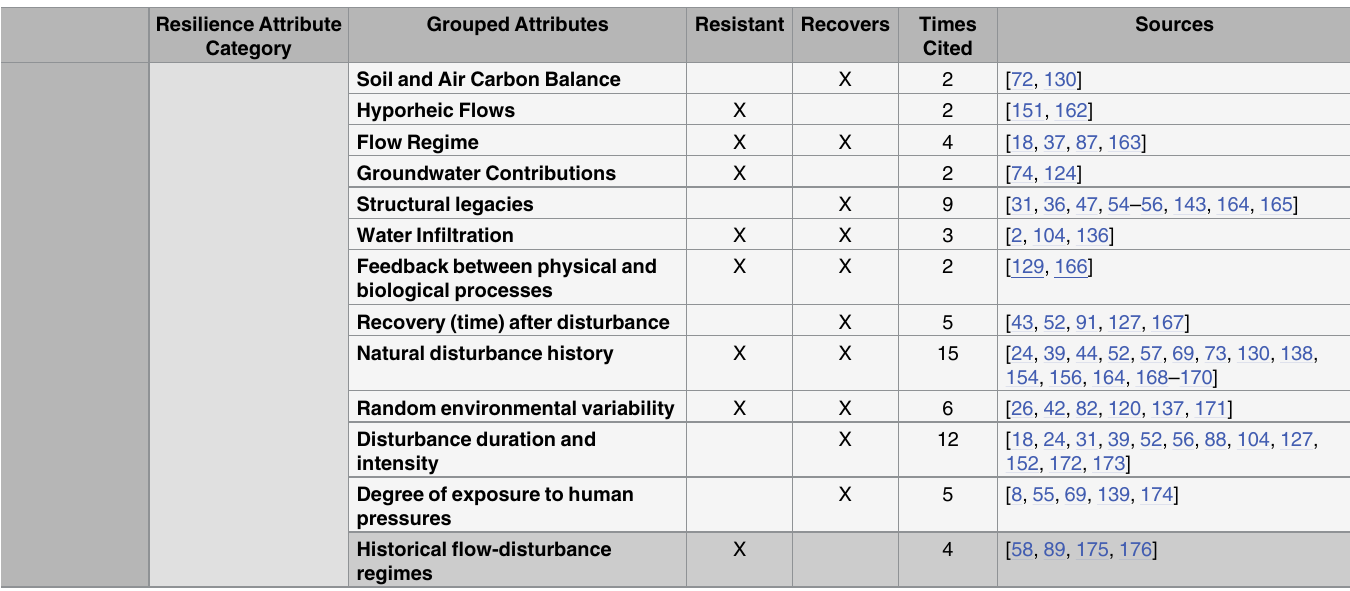
Each resilience attribute is listed and grouped into five major categories (Individual, Population, Community, Ecosystem, and Process) and whether the attribute was identified as resisting or recovering from disturbance in the literature is noted. In addition, the number of citations for each attribute and the corresponding references are detailed. Attributes highlighted in grey did not pass through the climate